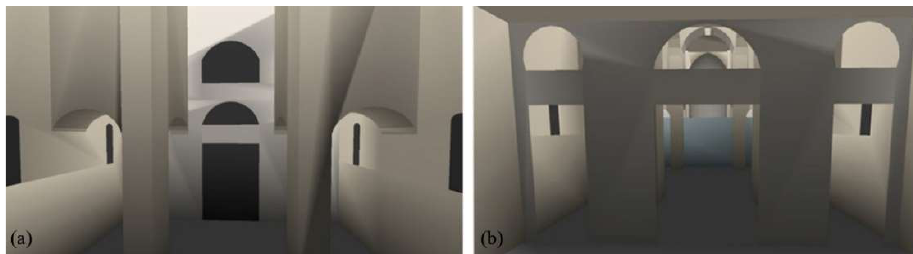
Figure 10. 3D Open GL of an interior view of Bell Church from ( a ) Phase I; ( b ) Phase II. For Phase II of the model, a two-storied narthex, with a wooden roof, is added to the main church space. The estimated volume of the Bell Church Phase II model is 1200 m 3 .